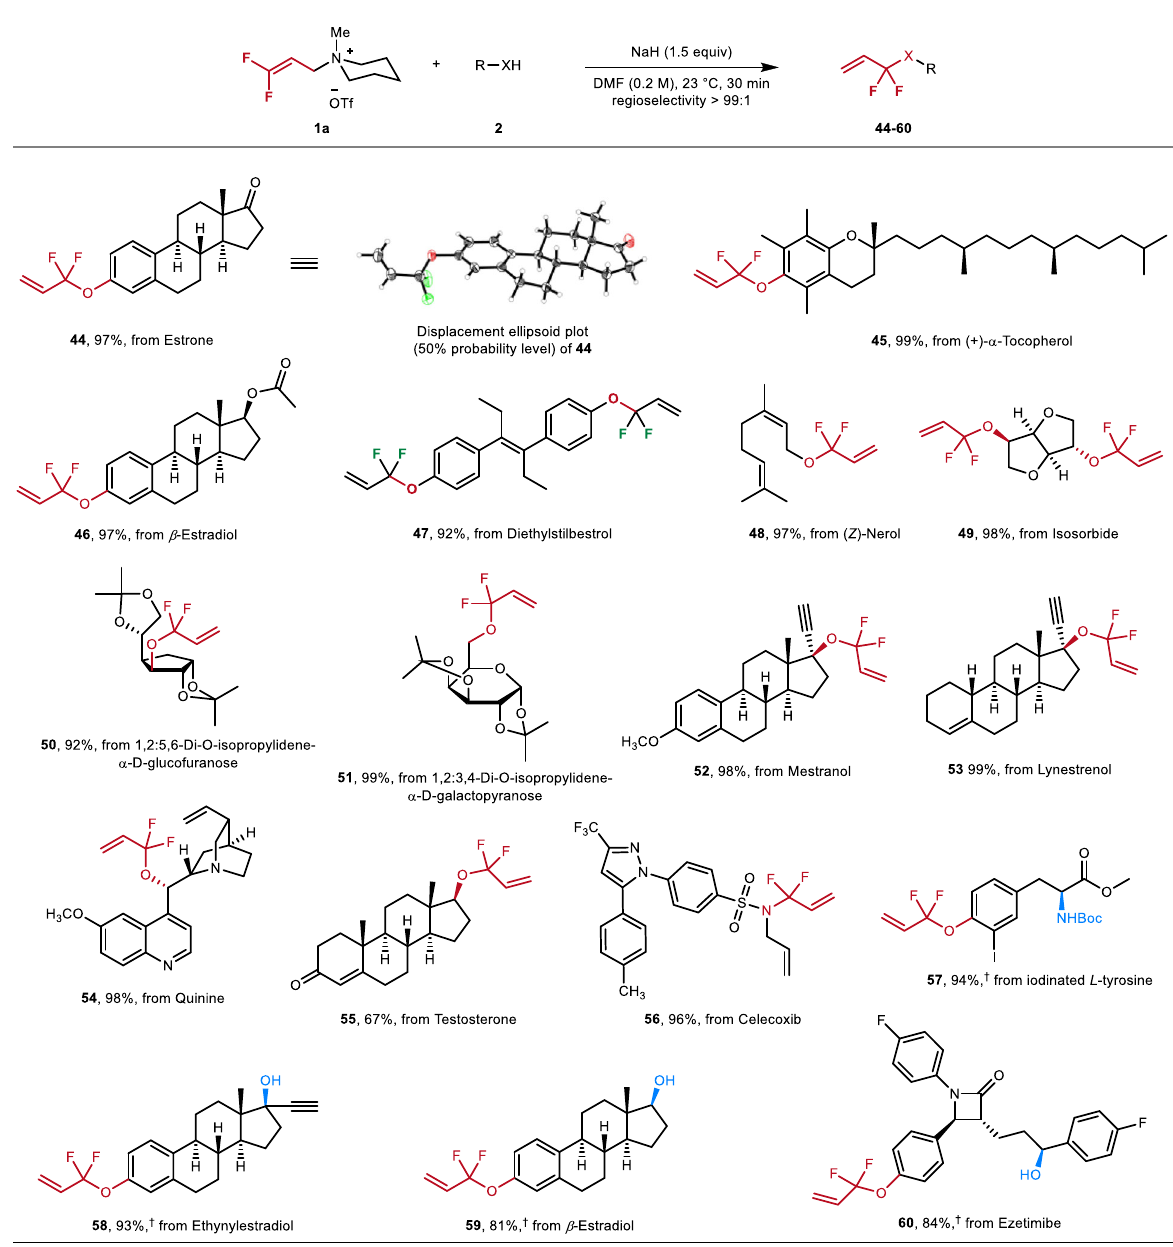
Fig. 4 Selective 1,1-di fl uoroallylation of natural products and pharmaceuticals. Standard reaction conditions: 1a (1.2 equiv), 2 (1 equiv), NaH (1.5 equiv) in DMF (0.2 M), the reaction mixture was performed at 23 °C under argon atmosphere for 30 min, isolated yield, the α / γ regioselectivity was determined by crude 19 F NMR analyses. † Cs 2 CO 3 (0.5 equiv) and toluene (0.1 M) were used as base and solvent, the reaction was performed at 50 °C under air atmosphere for 18